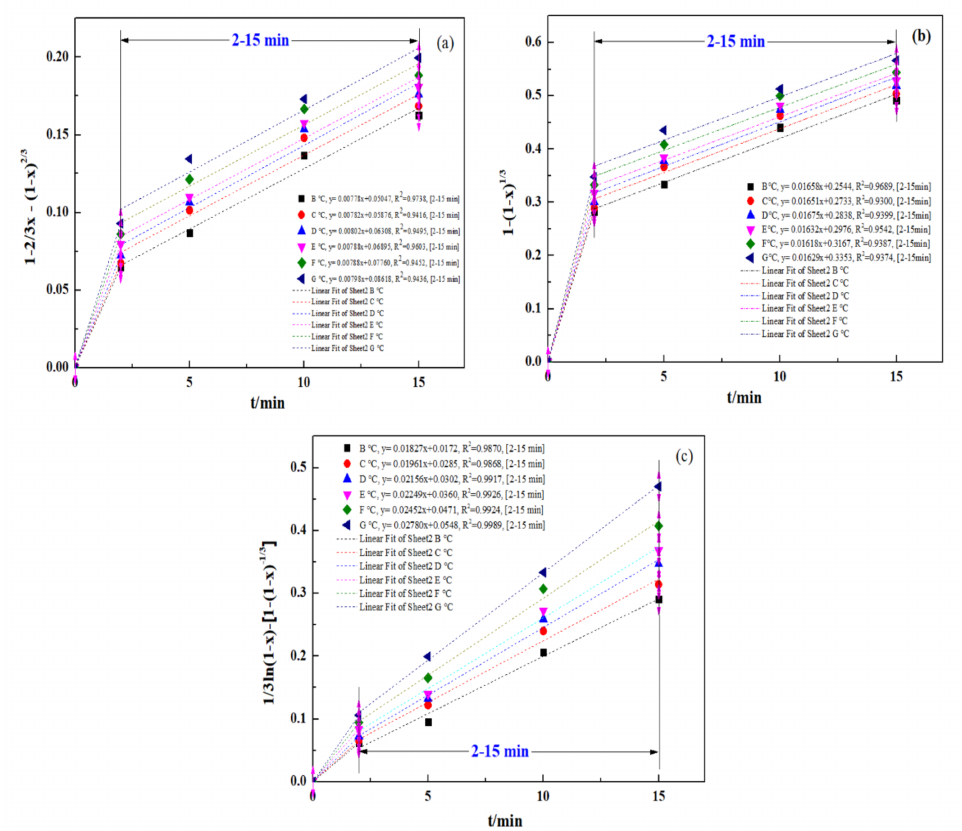
Figure 11. Plot of 1 − 2/3 x − (1 − x ) 2/3 , 1 − (1 − x ) 1/3 , and 1/3ln(1 − x)-[1 − (1 − x) − 1/3 ] vs. time for various temperatures: ( a ) 1 − 2/3 x − (1 − x ) 2/3 ; ( b ) 1 − (1 − x ) 1/3 ; and ( c ) 1/3ln(1 − x) − [1 − (1 − x ) − 1/3